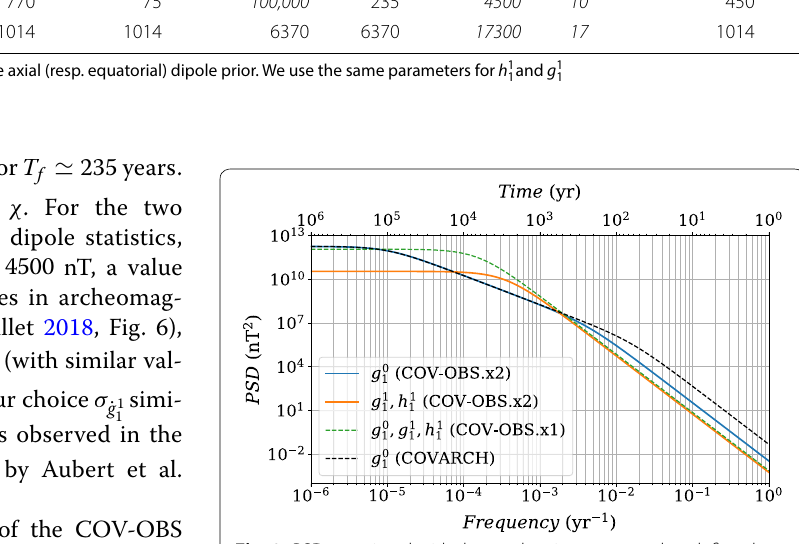
Fig. 2 PSD associated with the stochastic processes that define the a priori information used for the construction of COV-OBS.x2 for the axial dipole (blue) and the equatorial dipole (orange) coefficients. Comparison with the corresponding PSD for the axial dipole in COV-ARCH ( Hellio and Gillet 2018, dashed black), and for all dipole coefficients in previous COV-OBS models (Gillet et al. 2013, 2015, dashed